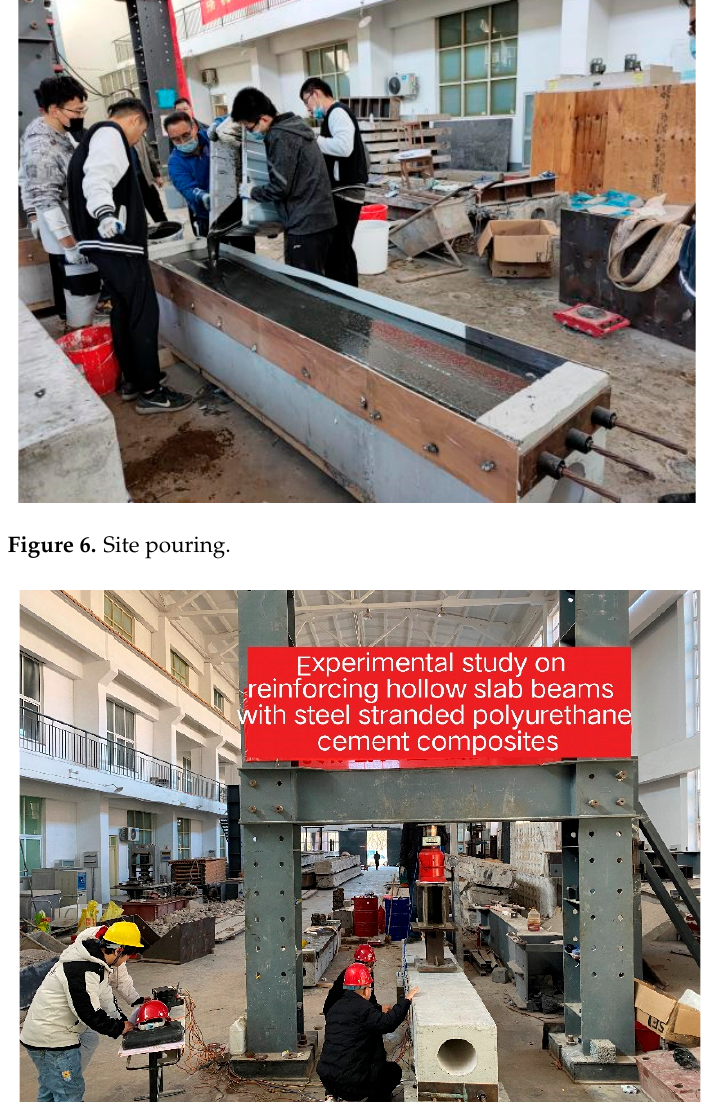
Figure 7. Field loading.